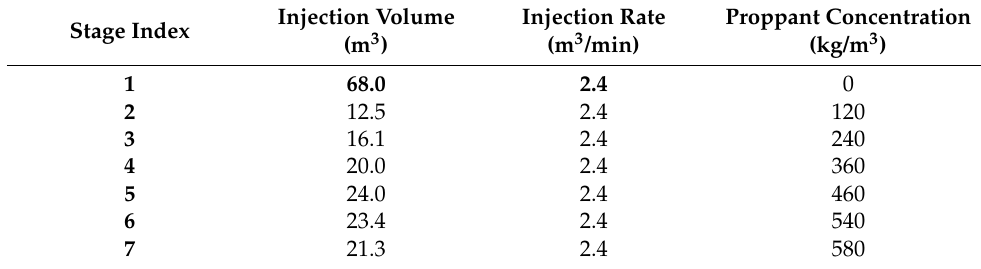
Table 6. Pumping schedules of the five cases. The stage index refers to the sequence of injected